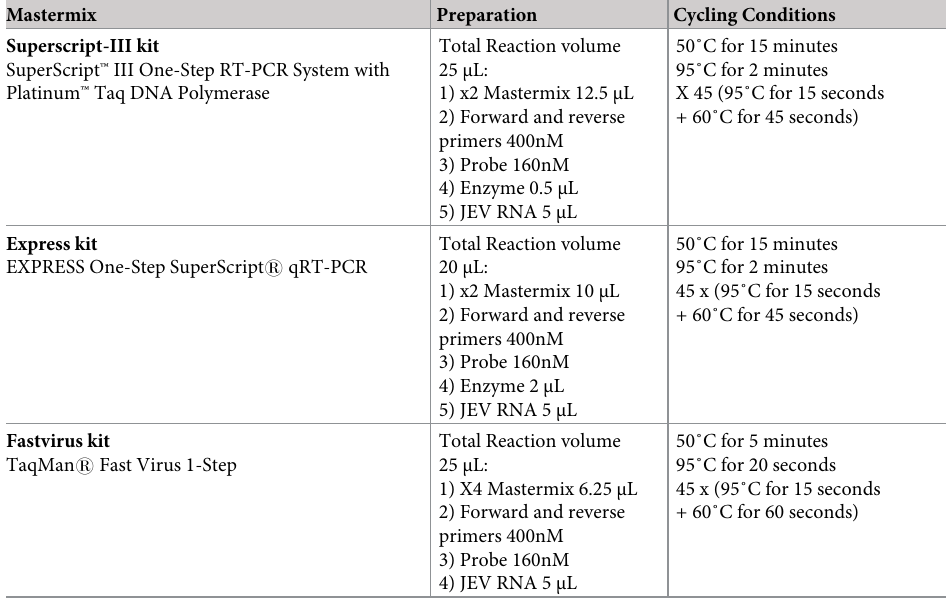
Table 1. Standard reaction mixes and cycling conditions.